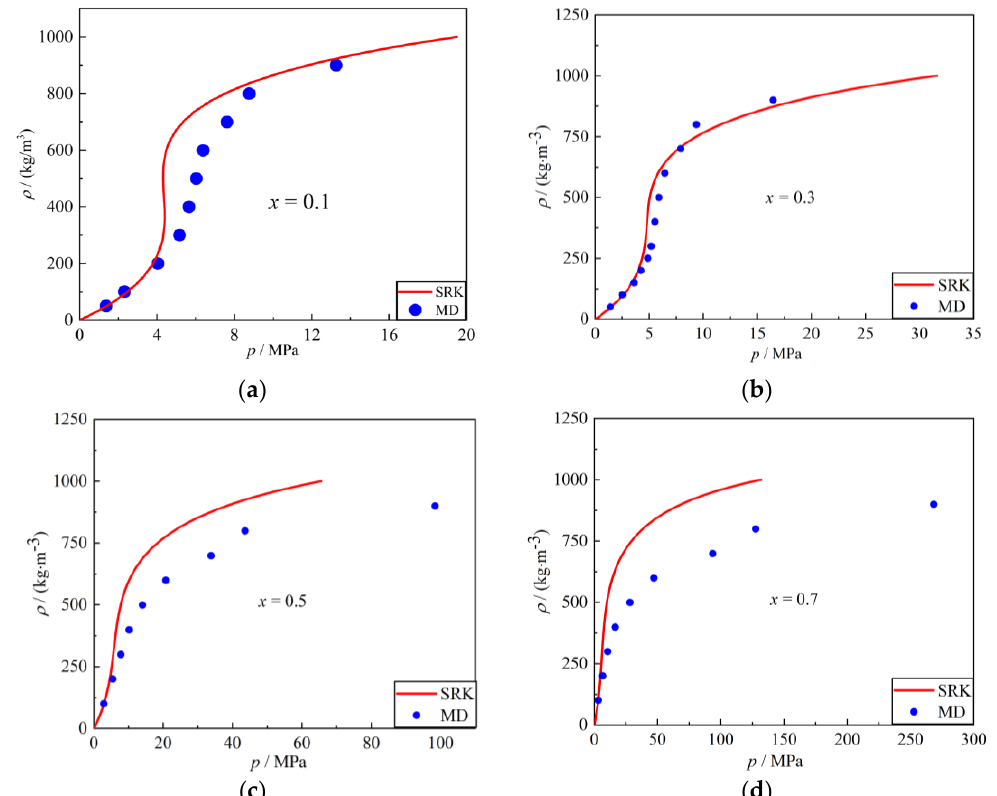
Figure 10. Results of molecular dynamics comparing SRK EOS with different mixing ratio of nitrogen: ( a ) x = 0.1; ( b ) x = 0.3; ( c ) x = 0.5; ( d ) x = 0.7.